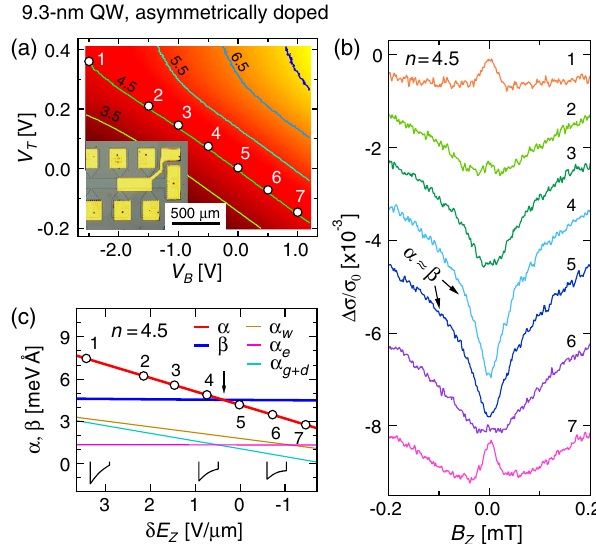
FIG. 2. Weak localization (WL) as an α ¼ β detector, gate control of Rashba α at constant density. (a) Measured charge density n (color) versus top gate voltage V and back gate voltage T V (9.3-nm well). Contours of constant density ð 3 . 5 – 7 . 5 Þ × B 10 11 cm − 2 are shown. Inset: Optical micrograph of typical Hall bar, with contacts (yellow), gate (center), and mesa (black lines). Þ − (b) Normalized longitudinal conductivity Δ σ = σ 0 ¼ ½ σ ð B Z σ ð 0 Þ(cid:2) = σ ð 0 Þ versus B ⊥ 2 D plane. Curves for gate configurations Z 1 – 7 along constant n ¼ 4 . 5 × 10 11 cm − 2 are shown (offset vertically), also labeled in (a) and (c). (c) Simulated Rashba α and Dresselhaus β coefficients (see text) against gate-induced field change δ E , shown for constant n ¼ 4 . 5 × 10 11 cm − 2 . The Z δ E axis — decreasing from left to right — corresponds exactly to Z abscissa of (a) for a covarying V , such that n ¼ 4 . 5 × the V B T 10 11 cm − 2 constant. Sketches of the well potential at 1, 4, and 6 ¼ 0 Þ ≠ 0 illustrate the change of α with δ E . Note that α ð δ E Z Z ¼ 0 since the external E field (see SM [18]) is not zero at δ E Z donor electric fields [21,22] is negligible in our structures; see SM [18].